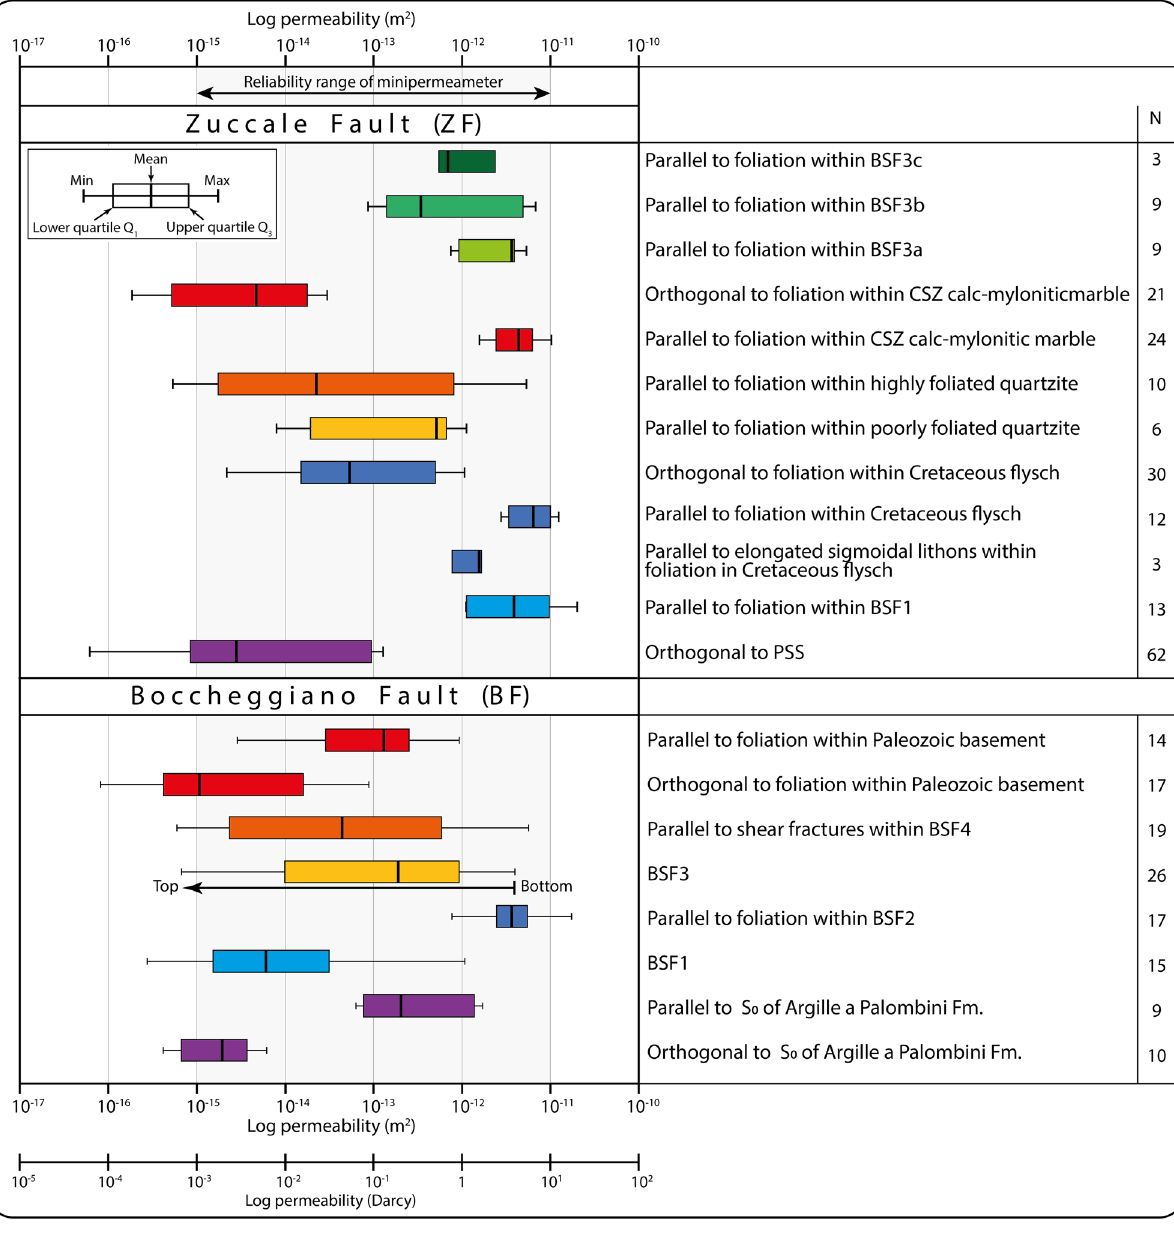
Figure 8. Results from in-situ outcrop air-permeability (m 2 , D) along the Zuccale Fault and Boccheggiano Fault. The corresponding BSF, structural elements, and orientation of measurements with respect to the tectonic foliations are reported. N: number of measurements. Each box of the box-and-whiskers plot represents the range between the 1st and 3rd quartile of the distribution. The whole data range is represented by the extension of the